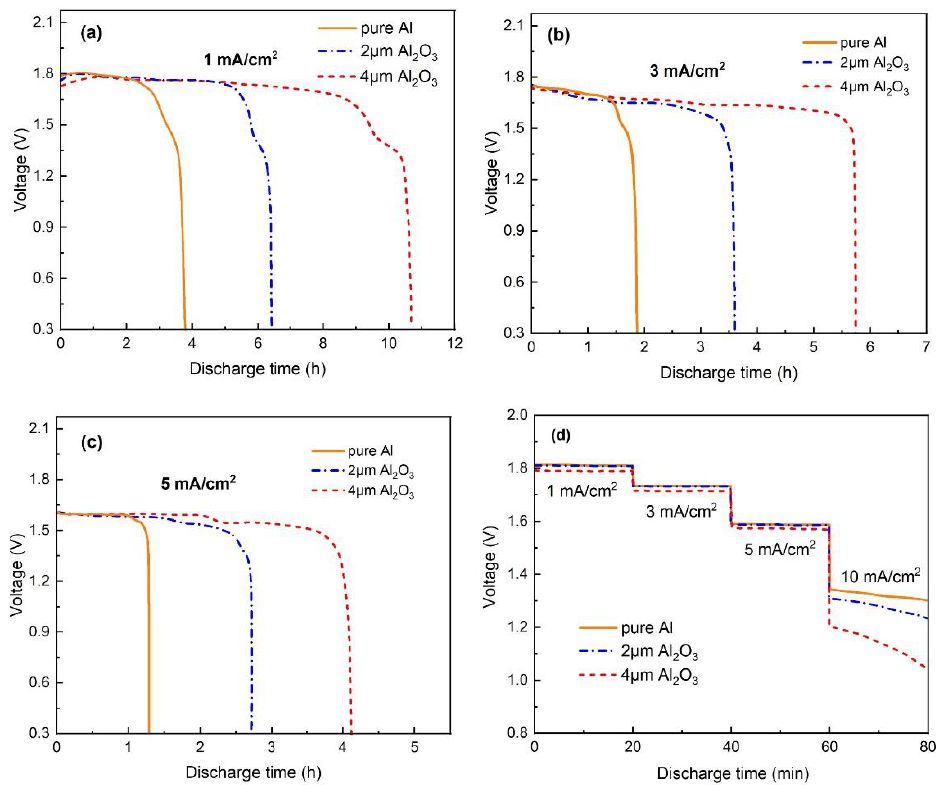
Figure 8. Discharge curves of the Al–air batteries modified by Al 2 O 3 interlayers with different thicknesses at ( a ) 1, ( b ) 3, ( c ) 5 mA/cm 2 and ( d ) rate discharge.